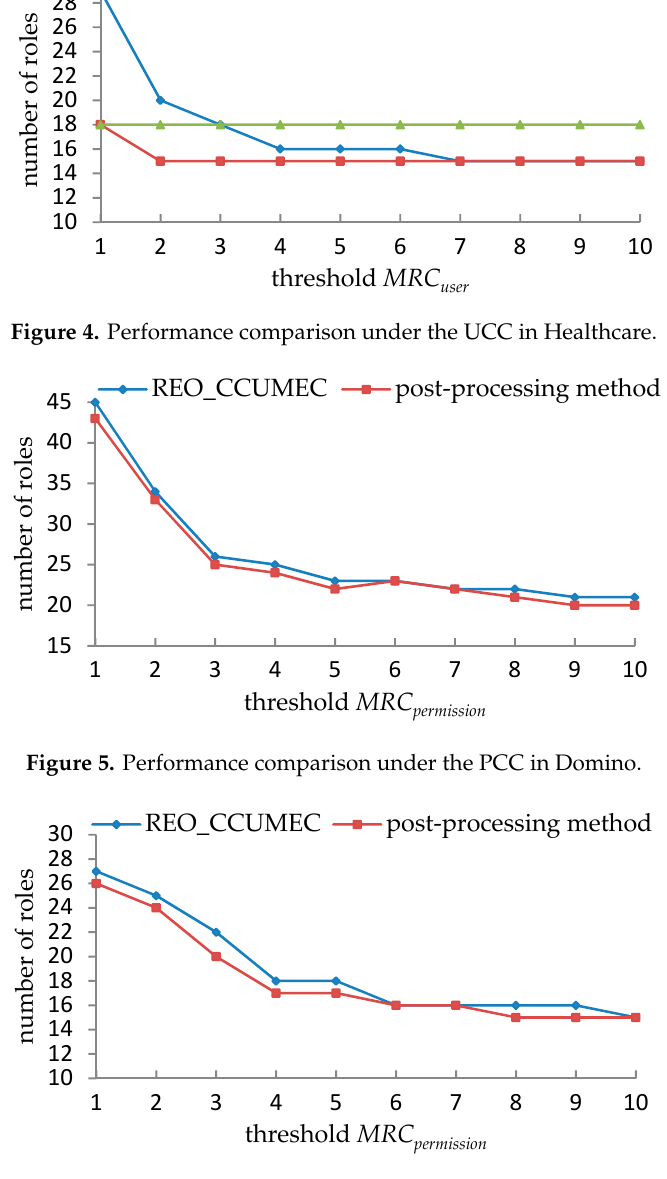
Figure 6. Performance comparison under the PCC in Healthcare.